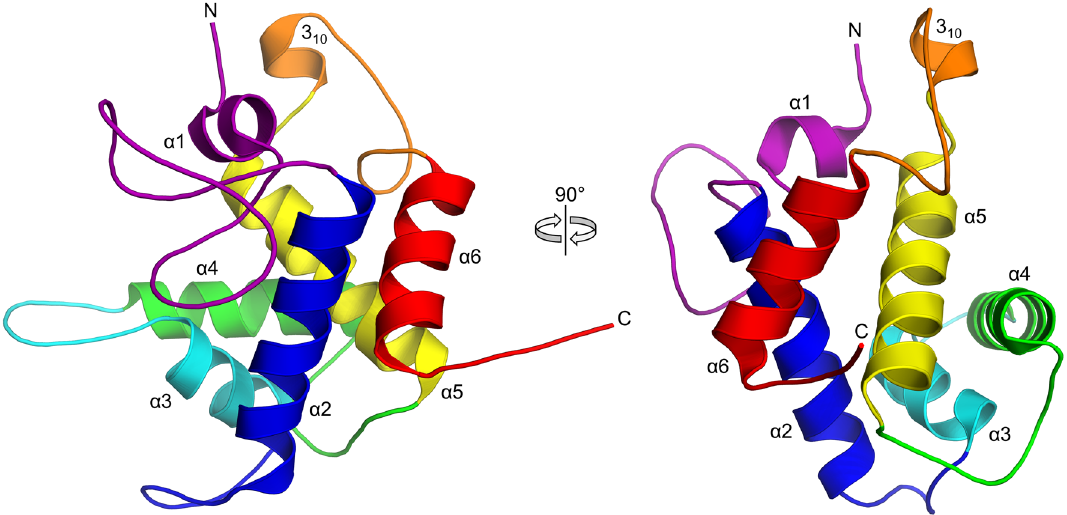
Figure 2. Three-dimensional structure of the Enc34 endolysin. The protein chain is rainbow-colored purple to red from the N- to the C-terminus. This and other structure figures were prepared using PyMOL 24 .